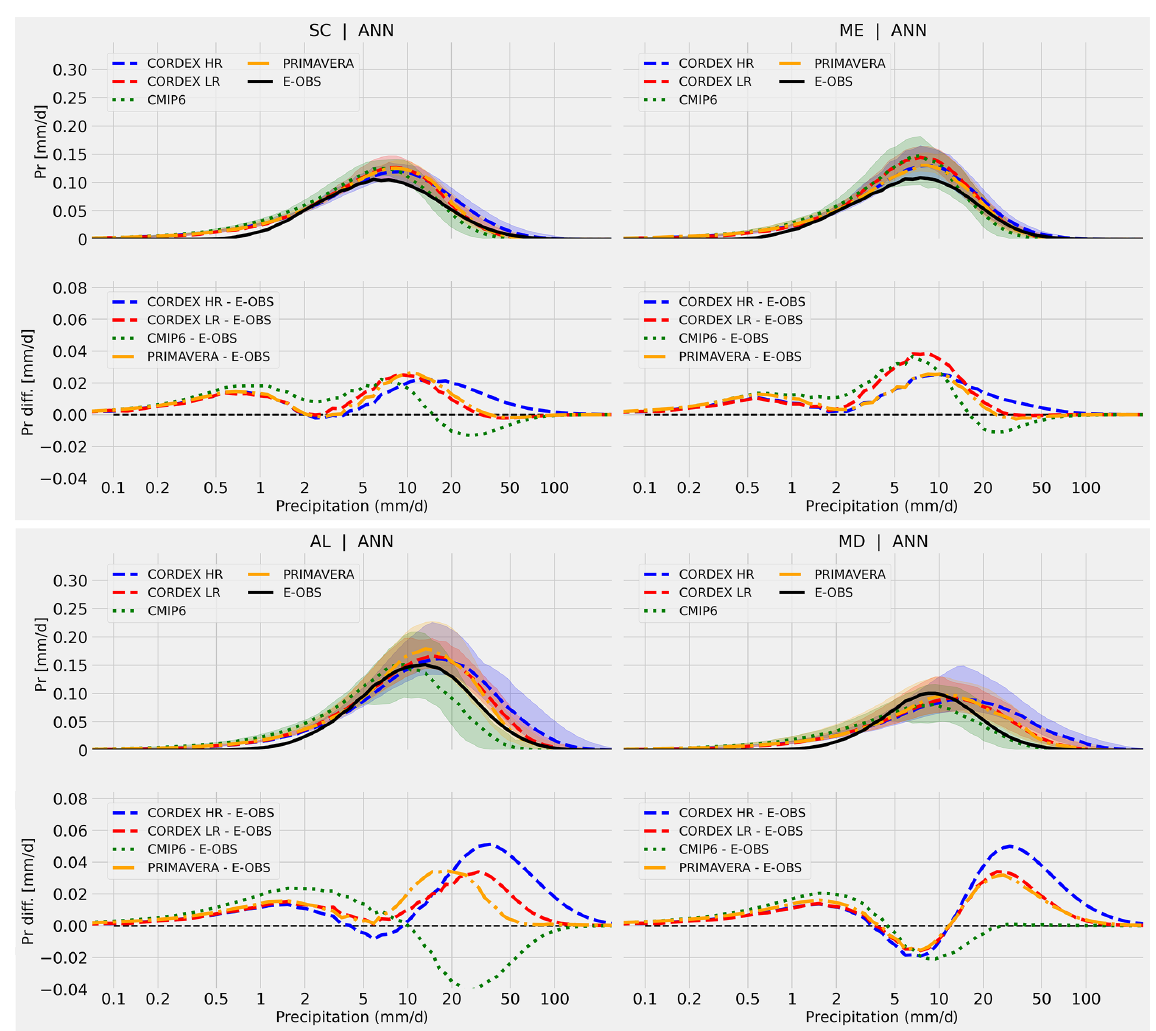
Figure 2. The panels show the actual contribution (to the total median precipitation, y axis) per precipitation intensity bin ( x axis), based on annual (ANN) daily precipitation values in the CMIP6 (green dotted lines and shading), PRIMAVERA (orange dashed–dotted lines and shading), CORDEX low-resolution (red dashed lines and shading), and CORDEX high-resolution (blue dashed lines and shading) ensem- bles. The displayed regions are Scandinavia (SC, top left), mid-Europe (ME, top right), the Alps (AL, bottom left), and the Mediterranean (MD, bottom right). Coloured shadings represent the 5–95th percentile range in respective ensemble. Black solid lines are E-OBS (0.1 ◦ resolution)